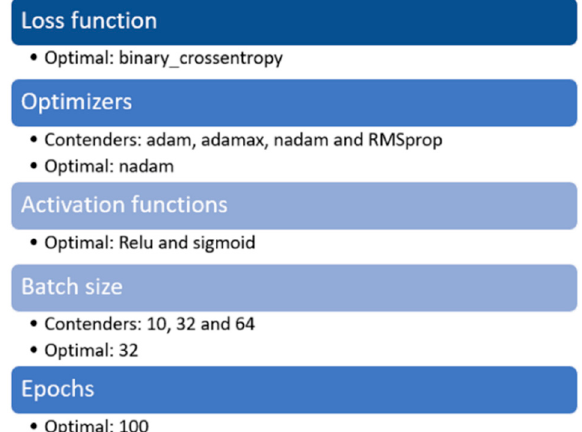
Figure 3. Optimal parameters.